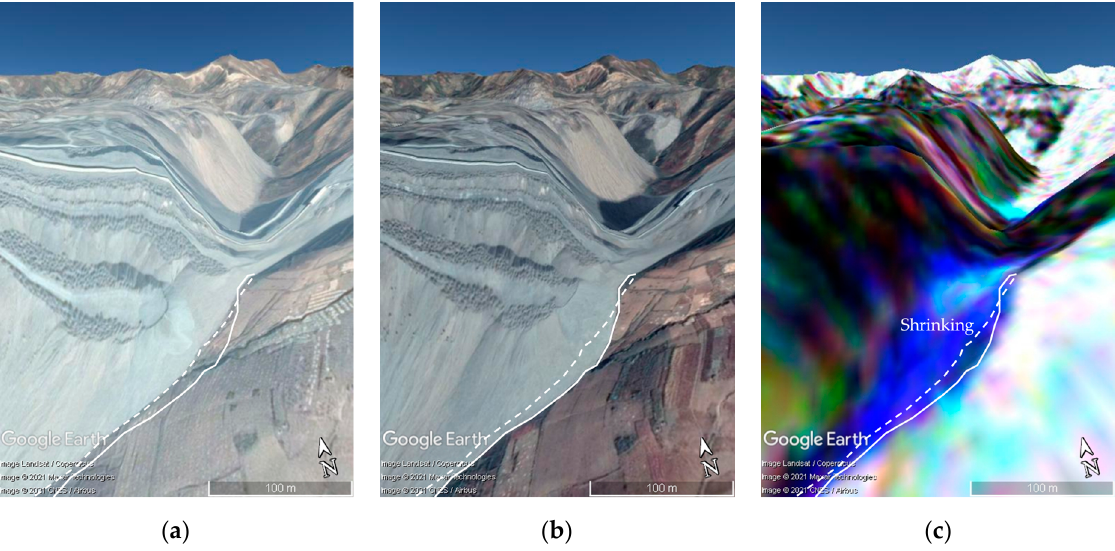
Figure 21. East Dumping Site 2 (ED2). ( a , b ) are Google Earth images taken on 7 October 2015 and 26 September 2019, respectively. ( c ) is the RGB composite of the annually averaged NDAI map (R: 2019, G: 2018, and B: 2017). Dashed lines are drawn based on the 2015 Google Earth image, while solid lines are on 2019.